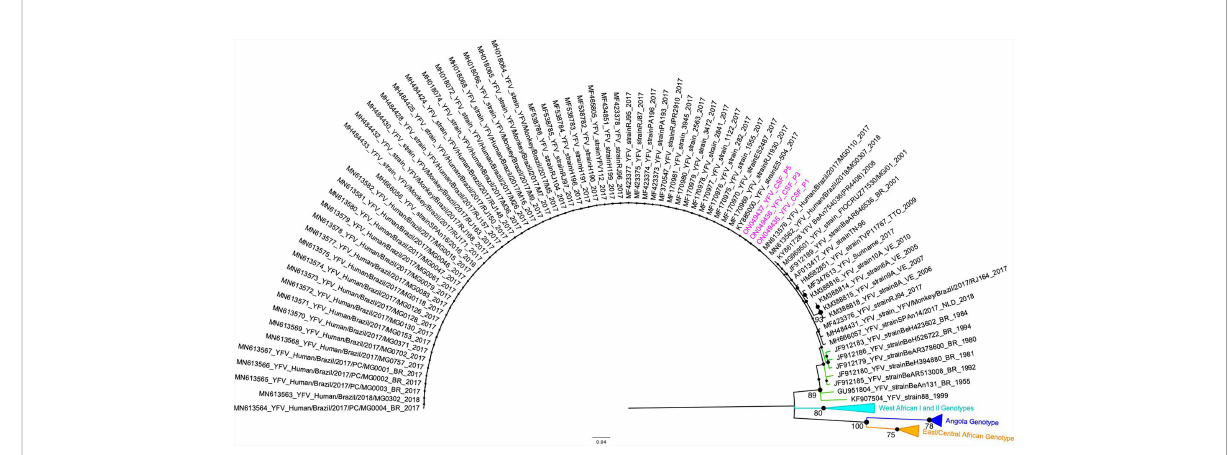
FIGURE 1 Maximum Likelihood tree of Yellow fever virus. The maximum clade credibility tree inferred using Yellow fever virus (YFV) sequences (187 nt) is shown (corresponding to position 9046 to 9232 compared to the YFV nucleotide sequence, GenBank accession number KY885001). The bootstrap values (1.000 replicates) are represented by circles drawn in scale in the nodes. Bootstrap values higher than 75 are indicated. Sequences generated in this study are highlighted in pink. The clade containing samples from the genotype South-American I is represented in black. The clade containing samples from genotype South-American II is represented in green. For clarity purposes, some branches representing different genotypes were collapsed and colored as follows: West African I and II (light blue), Angola (dark blue), and East/Central African (orange), respectively. The tree was reconstructed using the nucleotide substitution model kimura 2-parameters with 4-categories gamma distribution. The analysis was performed using MEGA7 and the tree was visualized and edited in FigTree